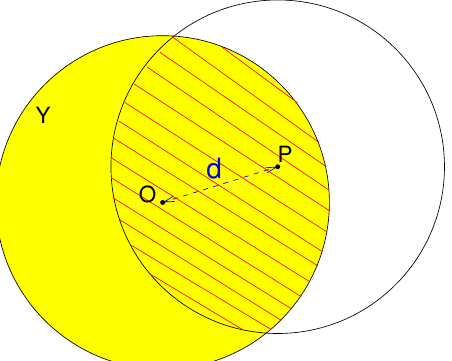
Figure 5. The value of EPS was considered unity inside the yellow-colored circular region of radius R with center at O—this disk was called region “Y” in the text—and zero outside. The (cid:104) EPS (cid:105) was calculated for a point P lying at distance d from the center of the yellow-colored region and equals to the ratio of the (red) line-shaded region over the area π R 2 of the circle having its center at